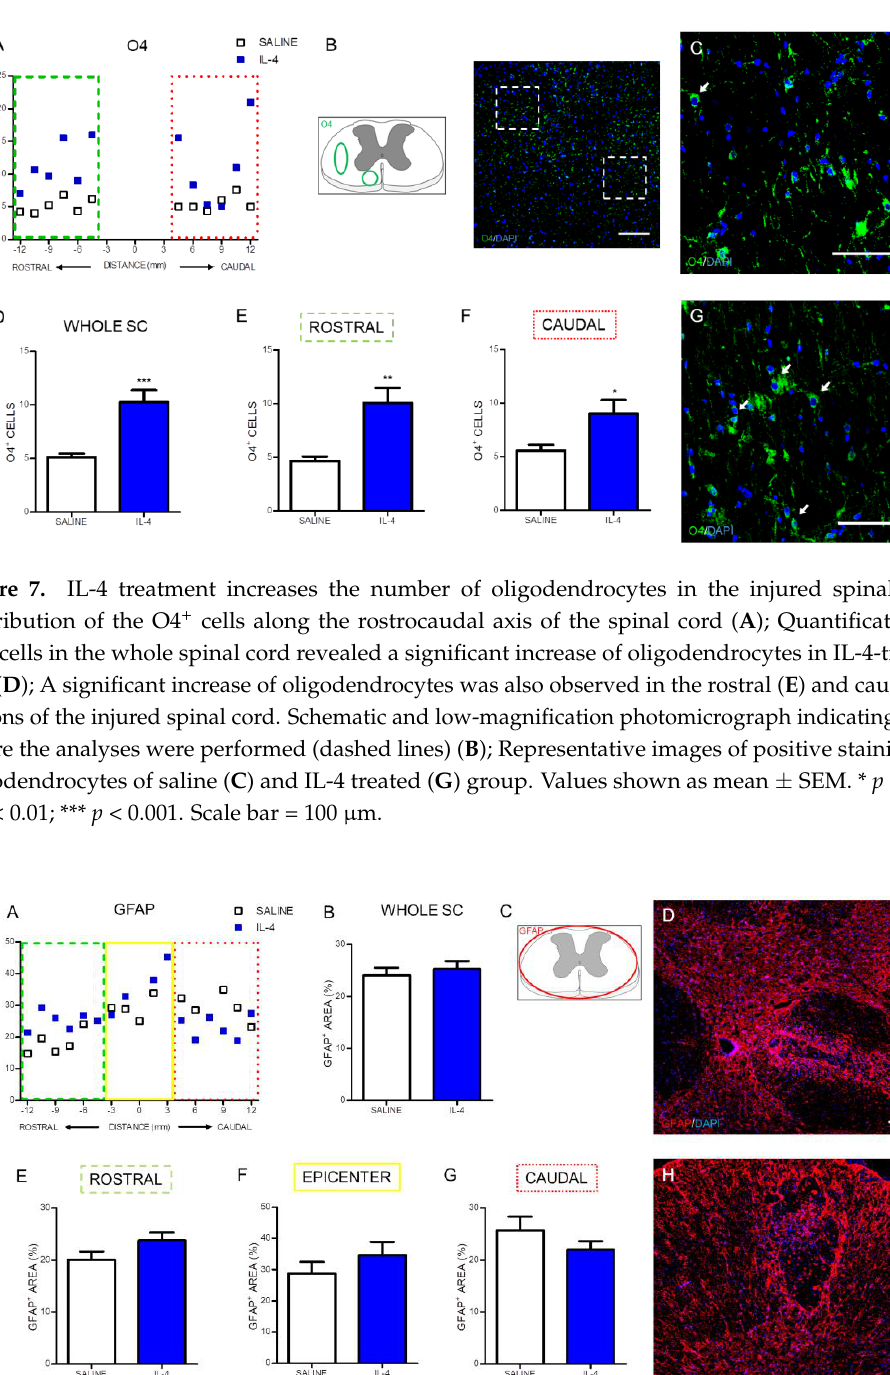
Figure 8. IL-4 treatment does not affect astrocyte numbers after SCI. Distribution of the percentage of GFAP + area along the rostrocaudal axis of the spinal cord ( A ); The quantification of GFAP + area either in the whole spinal cord ( B ) or in the specific regions (rostral ( E ); epicenter ( F ) and caudal ( G )) did not reveal any differences in astrocytes’ numbers. Schematic image indicating areas where the analyses were performed ( C ); Representative images of positive staining for astrocytes of saline ( D ) and IL-4 treated ( H ) group. Values shown as mean ± SEM. Scale bar = 100 µm.